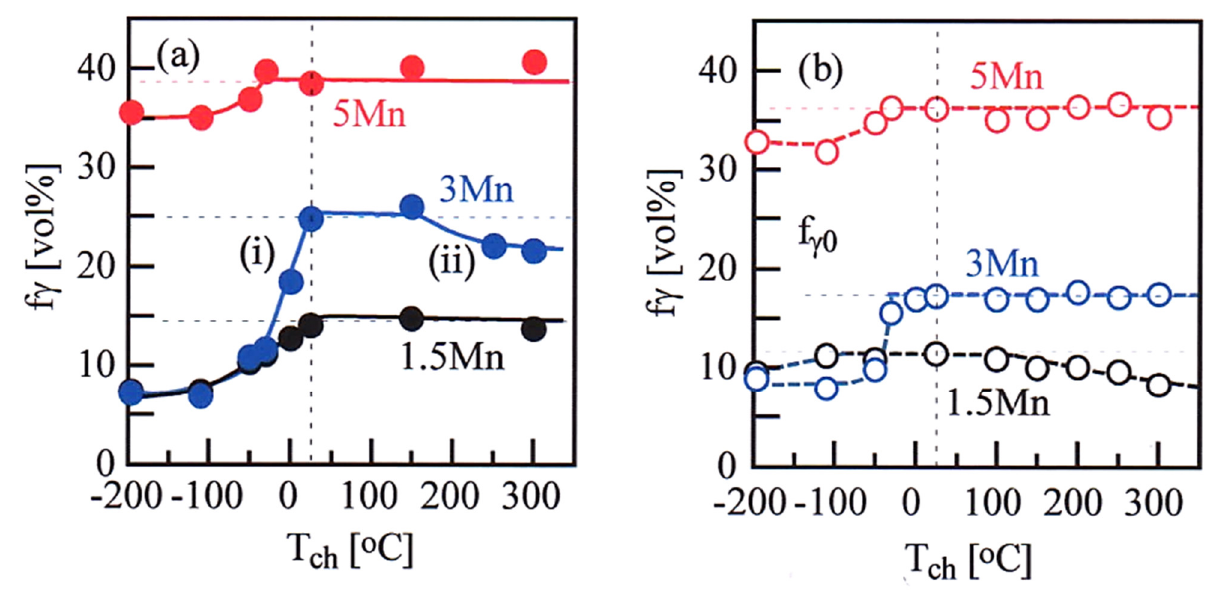
Figure 5. Variations in volume fraction of reverted austenite with cooling and heating temperature ( T ch ) in the 1.5 Mn, 3 Mn, and 5 Mn steels subjected to ( a ) the AC and ( b ) IT processes. (i) and (ii) in ( a ) represent the decreases of reverted austenite by ε -martensite transformation [36] and bainite transformation (or decomposition into ferrite and carbide) [35], respectively. ( b ) is reprinted with permission from Wily-VCH GmbH, Weinheim: Steel Res. Int., Copyright 2021.